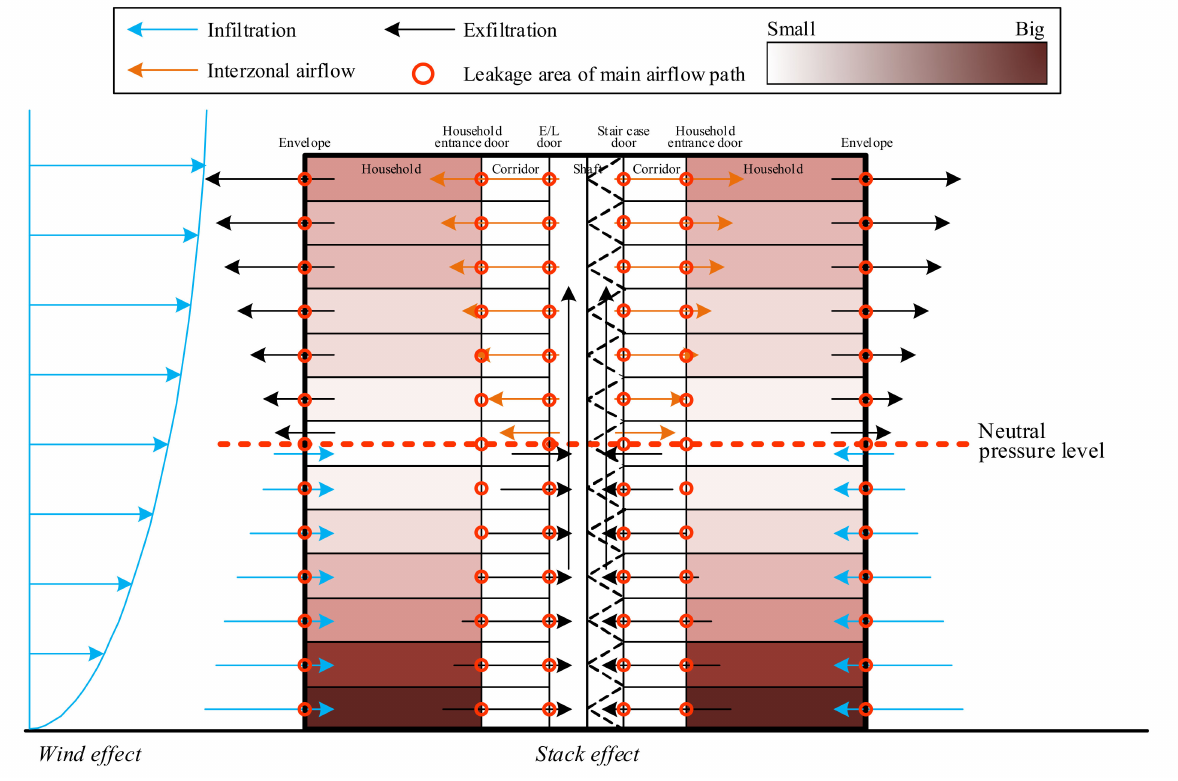
Figure 1. Air-driving forces and the associated heating load differences between floors in a